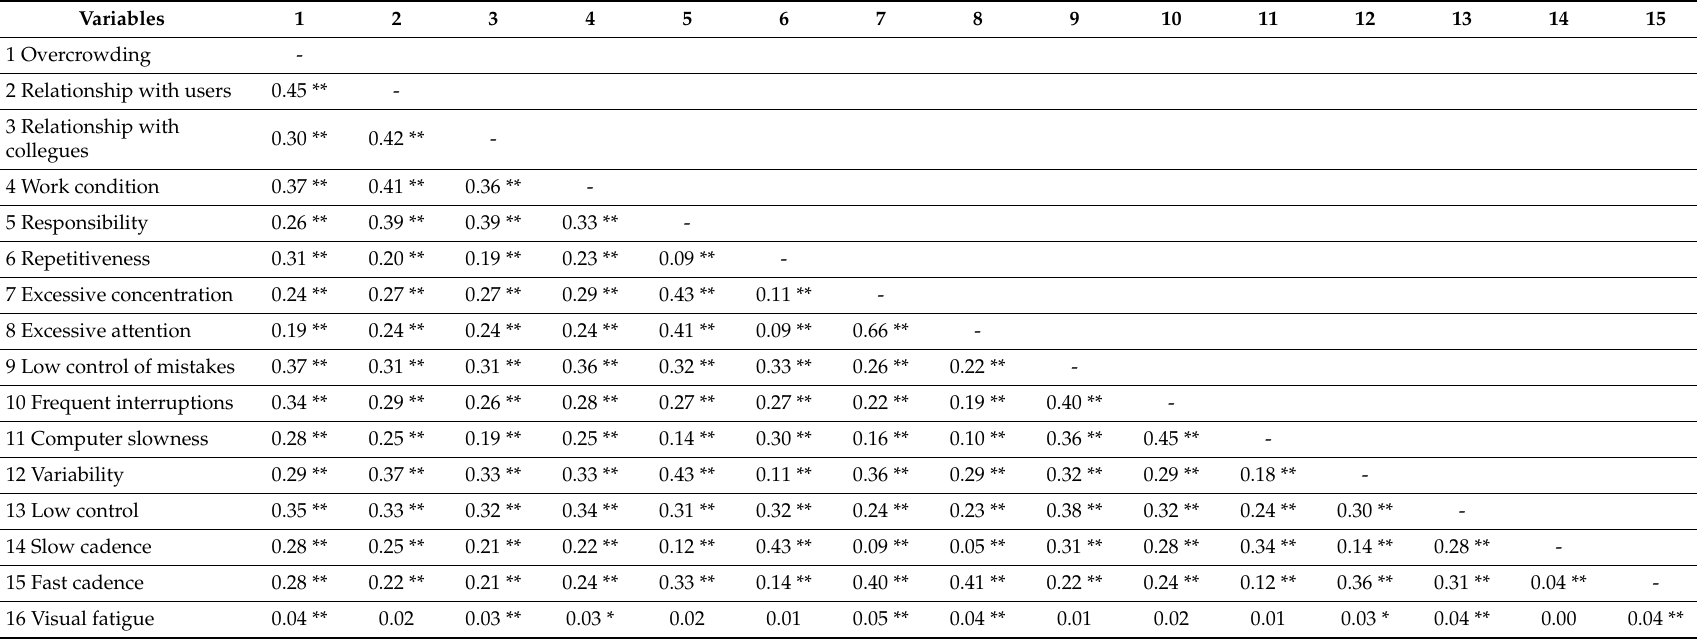
Table 3. Relationships between visual fatigue and psychosocial variables, analyzed using Pearson’s